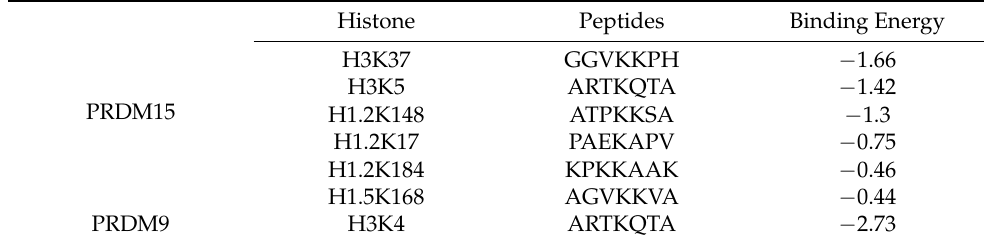
Table 2. The top-ranked six peptides from our 64